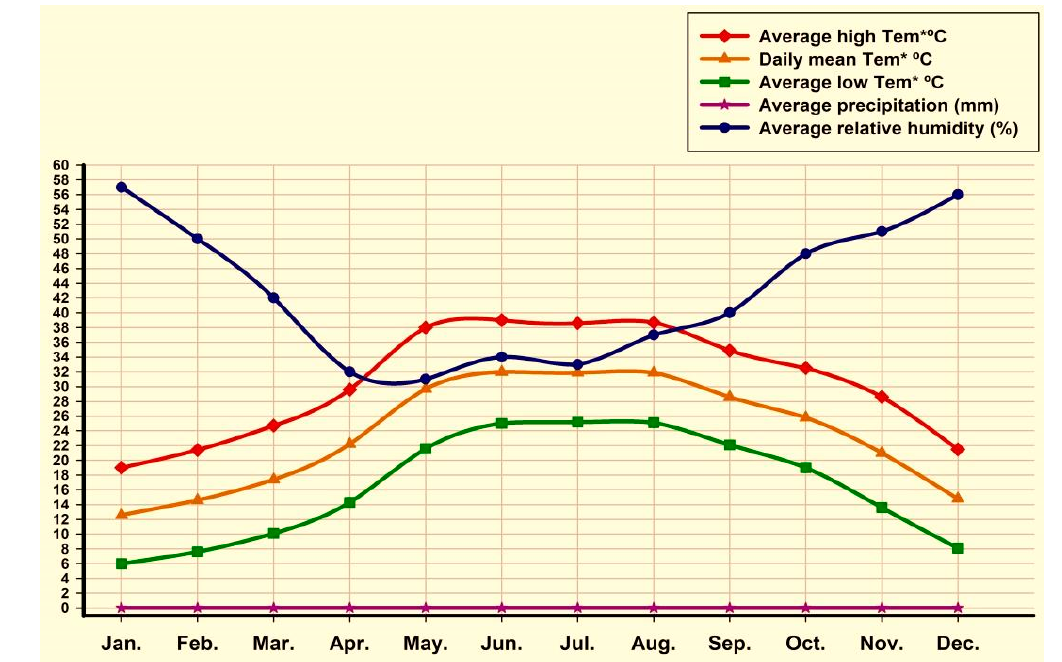
Figure 2. Climograph for the five years under investigation (Assiut Governorate). Tem* = Temper- ature.